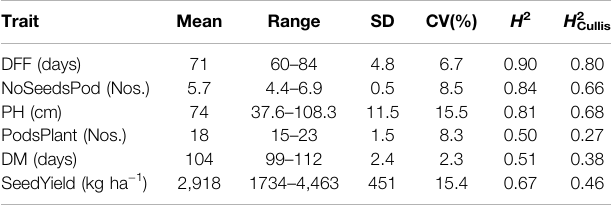
TABLE 1 | Heritability and summary statistics for seed yield and other agronomic traits.